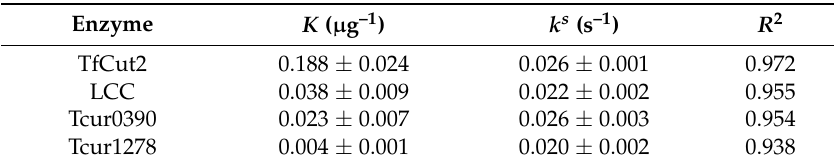
Table 1. Kinetic parameters of the enzymatic hydrolysis of Impranil DLN determined by the kinetic model proposed by Mukai et al. [39] (Equation